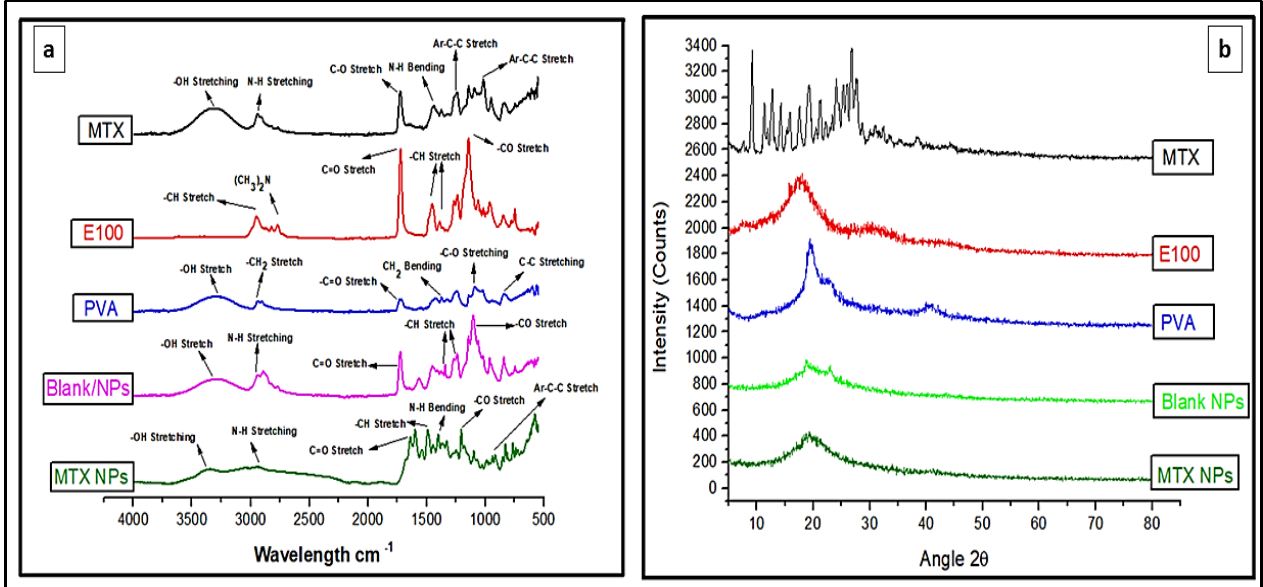
Figure 4. ( a ) FTIR spectra of MTX, E100, PVA, blank and MTX - NPs. ( b ) XRD spectra of MTX, E100, PVA, blank and MTX - NPs.